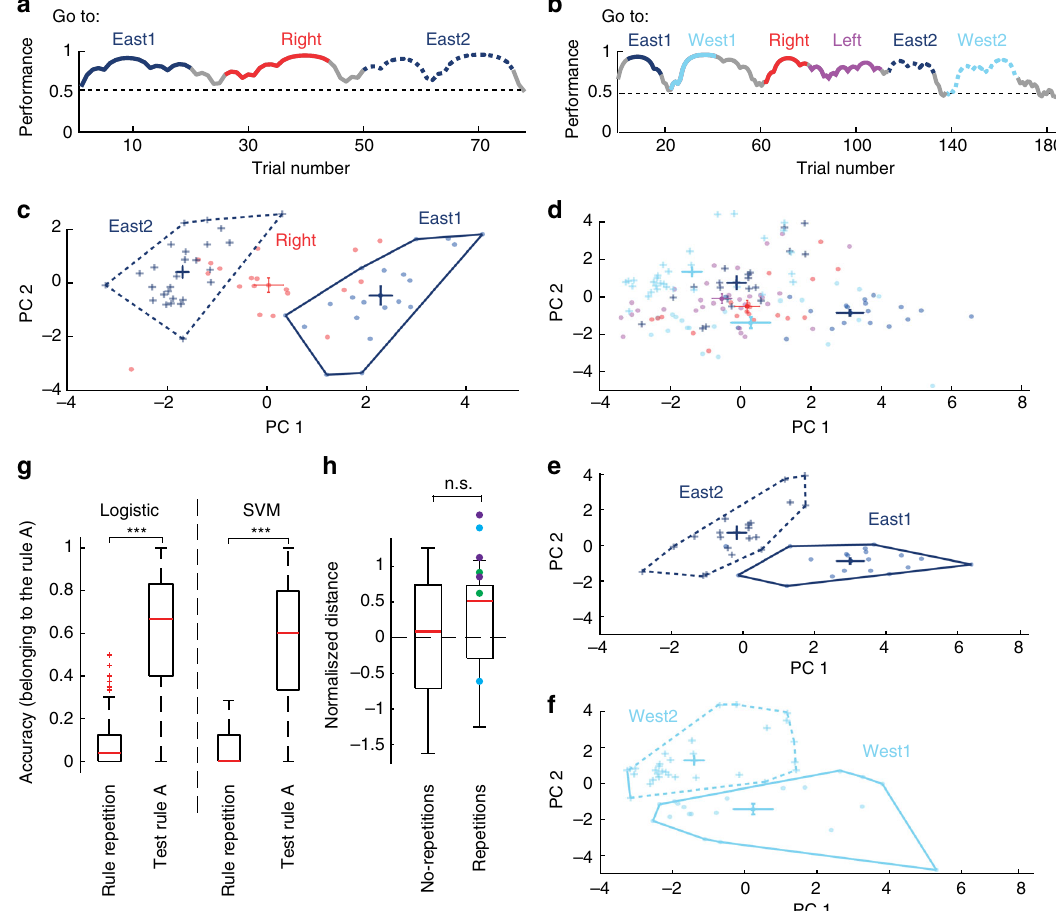
Fig. 5 The repeated presentation of the same rule is not accompanied with a reemergence of the same prefrontal network state of fi ring. a Behavioural session during which the animal performed successfully during three consecutive rules; the fi rst and the third rule applied were identical (go east). b Behavioural session with 7 rules presented. Two rules are presented twice at different times (go east and go west). Highlighted performance represents the trials used to calculate fi ring-states. c Projection of multi-unit activity ( n = 12 neurons) onto the two highest principal components for the session shown in ( a ). d Projection of multi-unit activity ( n = 18 neurons) onto the two highest principal components for the behavioural session shown in ( b ). Network states of different rules are colour coded and the centre of mass of each of them is presented with error bars. e , f Isolated and non-overlapping network states of two different rules (top and bottom), which were presented twice during the session example in b. Note that the rules presented twice at different times during the same session (dark and light blue, straight and dotted contours) resulted in different fi ring states of the network. g Comparison of the accuracy of two classi fi ers (logistic and support vector machine) trained to detect a given rule ‘ A ’ . Note that the classi fi ers can detect trials belonging the rule ‘ A ’ , but failed at detecting its repetition ‘ A° ’ as part of rule ‘ A ’ ( p < 1 × 10e − 20 for both logistic and SVM classi fi ers, Wilcoxon rank-sum test). Box plots show median, 25th and 75th percentile. h Box plot indicating the normalised Euclidean distance measured between the centres of rules without dimensionality reduction. Red line indicates the median. Coloured dots indicate different animals (Green = HM02, Blue = HM06 and purple = HM07). Note that distances of rules with or without repetitions of the same rule were not signi fi cantly different ( p = 0.58, Wilcoxon rank-sum test). Euclidean distances were normalised to account for a different number of rules which were presented between the same rule (see Methods). Box plots show median, 25th and